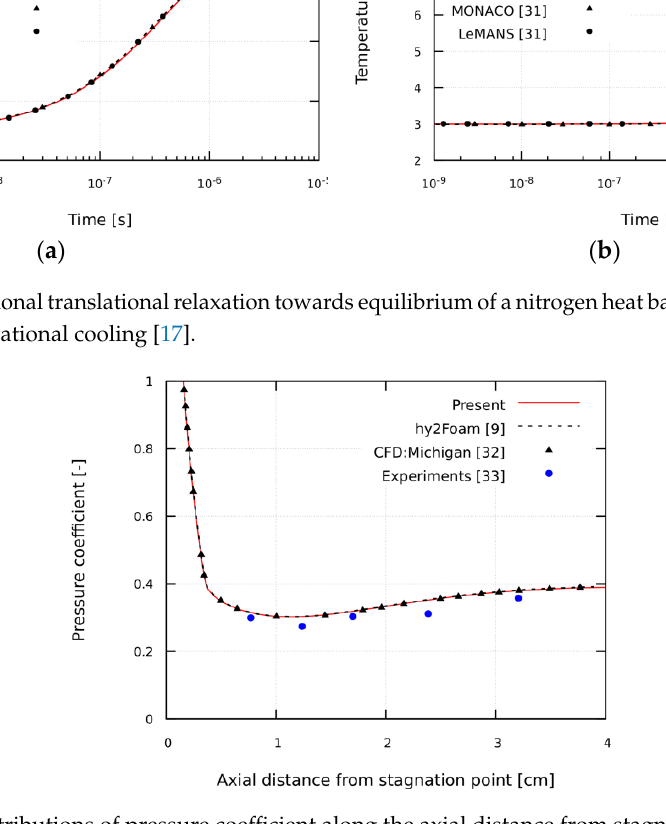
Figure 7. Distributions of pressure coefficient along the axial distance from stagnation point [9].